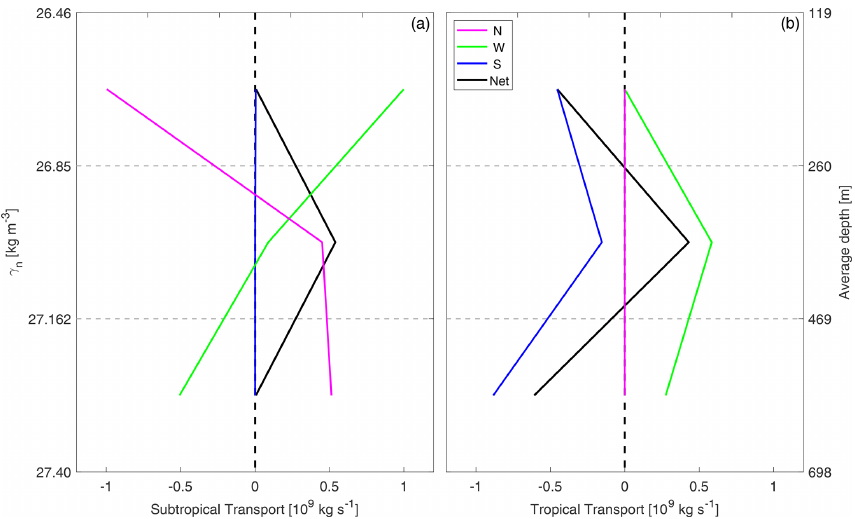
Figure 16. Mass transports (10 9 kgs − 1 ) integrated per transect north (N, pink line), west (W, green line) and south (S, blue line) of the subtropical (a) and tropical (b) areas separated by the CVF at the three CW layers (considering transports between WOA stations). The black line represents the net transport. Negative (positive) values indicate inward (outward) transports, as in Fig.